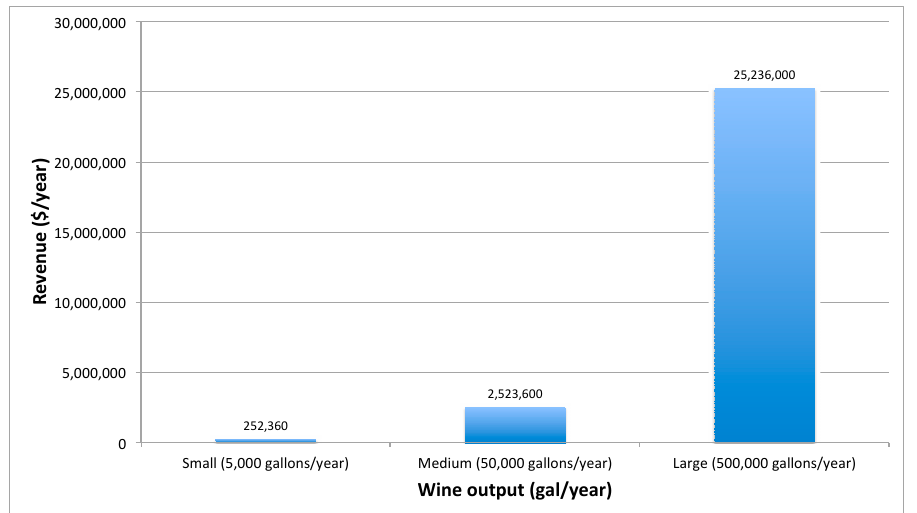
Figure 6. Allocation of annual production costs, according to type of cost and production scale. Note that many costs are impacted by economies of scale.